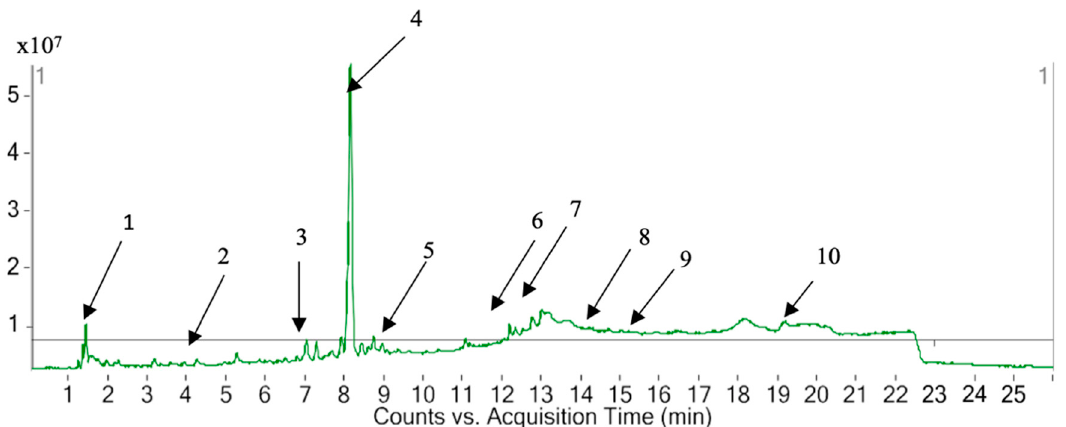
Figure 1. LC-MS chromatograms chemical compounds of P. hysterophorus in the positive ion mode (1. Valine, 2. umbellif- erone, 3. parthenin, 4. 9-hydroxyellipticine, 5. laciniatin, 6. phytosphingosine, 7. tridecylglycerol, 8. phthalic anhydride, 9. eicosasphinganine, 10. N,N-bis (2-hydroxyethyl) stearylamine).